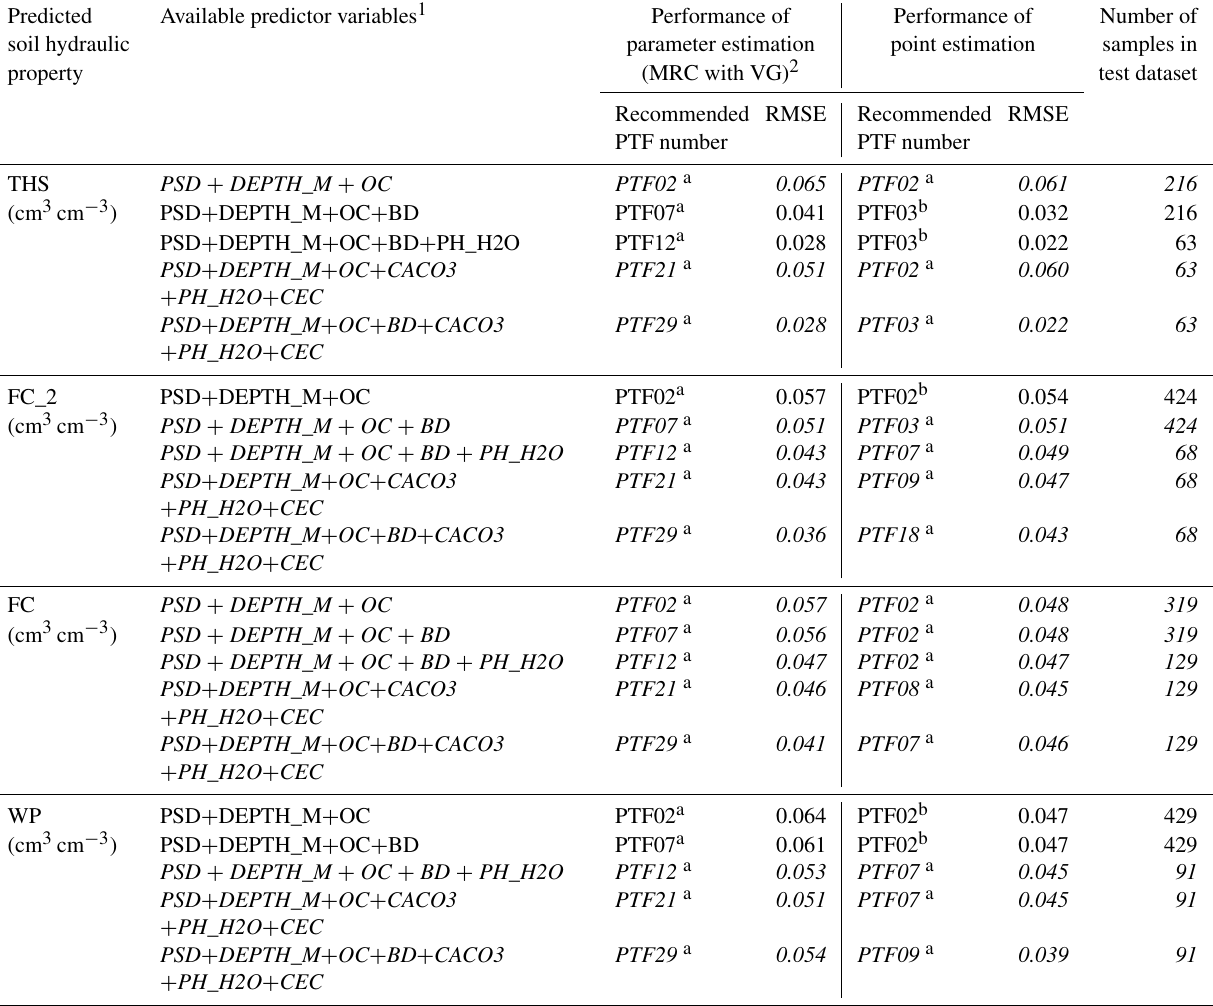
Table 9. The results of comparing the performance of parametric and point pedotransfer functions (PTFs) on the test sets of EU-HYDI to predict saturated water content (THS), water content at − 100cm matric potential head (FC_2), water content at − 330cm matric potential head (FC), water content at wilting point (WP). Rows in italic indicate cases where there was no significant difference between the two PTFs.